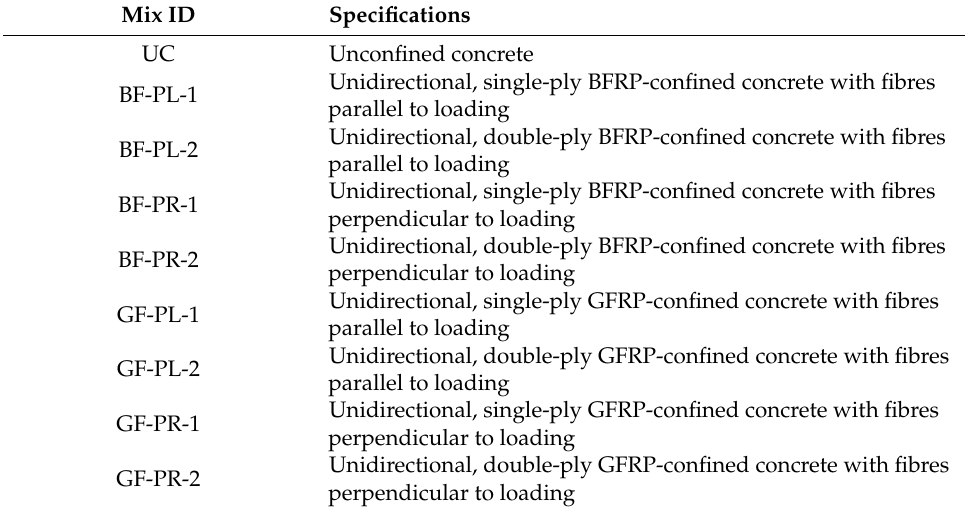
Table 5. Details of the